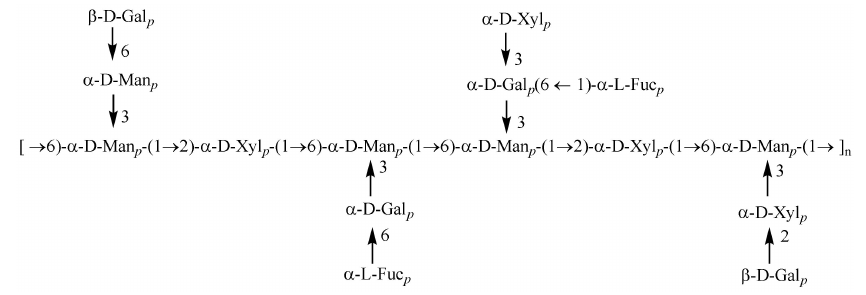
Figure 6. Possible structures of PAP-3 from P. aquilinum